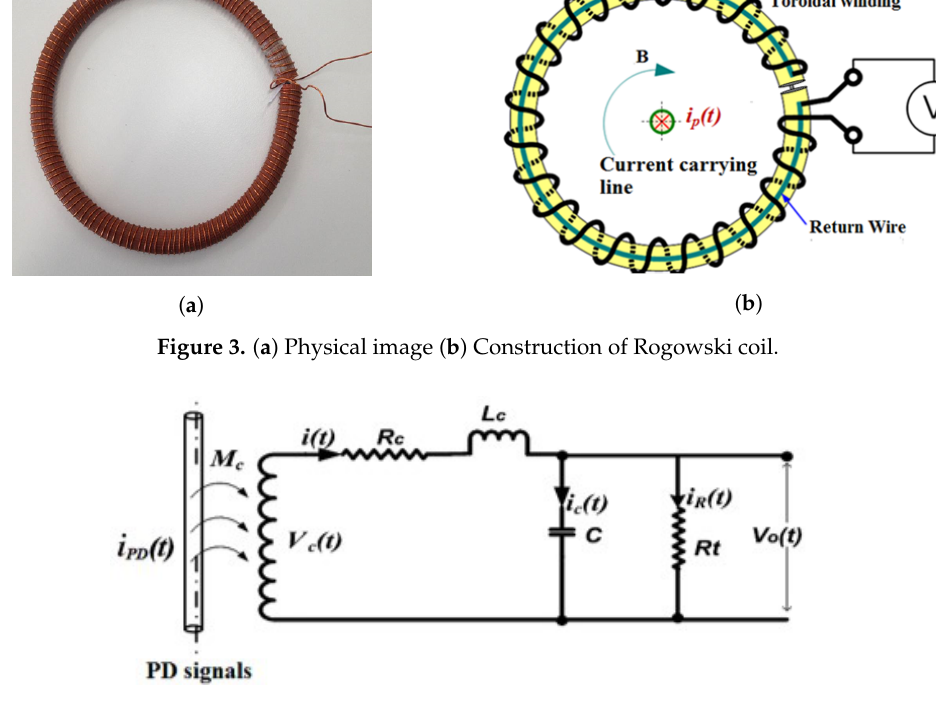
Figure 4. Electrical equivalent model of a Rogowski